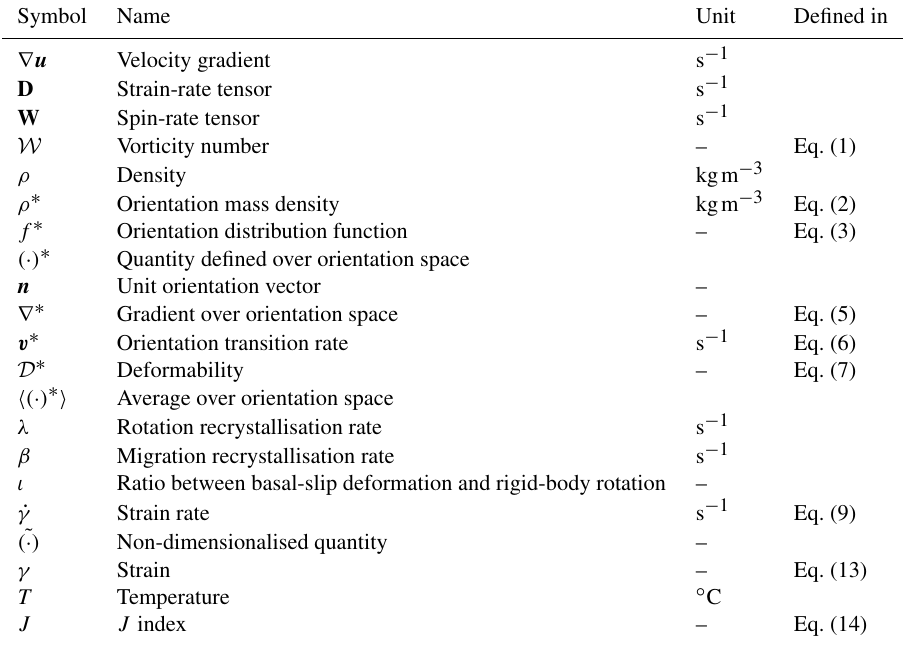
Table 1. List of mathematical symbols used in this paper, including units and the equation if they are explicitly defined. Symbol Name Unit Defined in ∇ u Velocity gradient s − 1 D Strain-rate